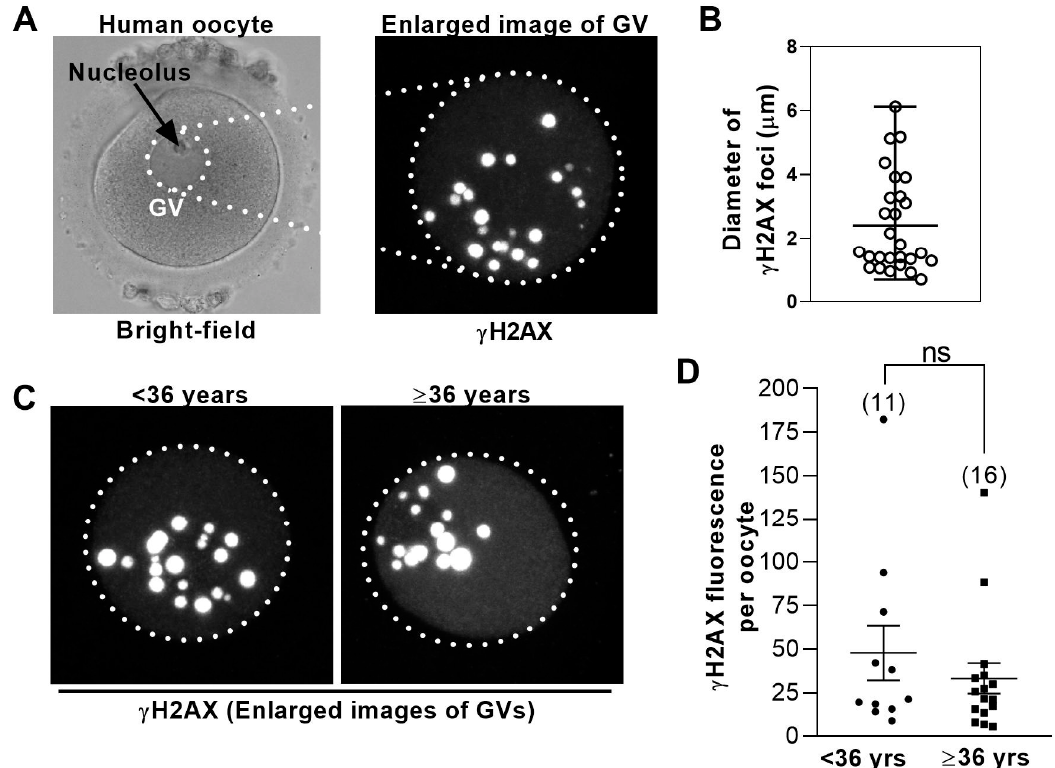
Figure 1. Levels of DNA damage in human germinal vesicle (GV) oocytes are not age-dependent. ( A ) Shown is a bright-field image of a GV − stage human oocyte (left); dotted circle highlights the GV. To the right is an enlarged view of the GV immunostained for γ H2AX. Shown is a maximum projection of multiple z-slices. ( B ) The sizes of γ H2AX foci in human GVs vary widely. The diameters of individual γ H2AX foci from the oocyte in (A) were measured using LAS software and plotted. Bars represent the mean and range. ( C ) Shown is the representative γ H2AX immunostained GVs from younger ( < 36 years of age) and older ( ≥ 36 years of age) women. Images are maximum projections of multiple z-slices. ( D ) Total γ H2AX fluorescence intensity within the GV was measured using confocal microscopy (see Methods) in oocytes from younger and older women (numbers of oocytes are shown in parenthesis) and plotted for each oocyte. Bars represent mean and SD.